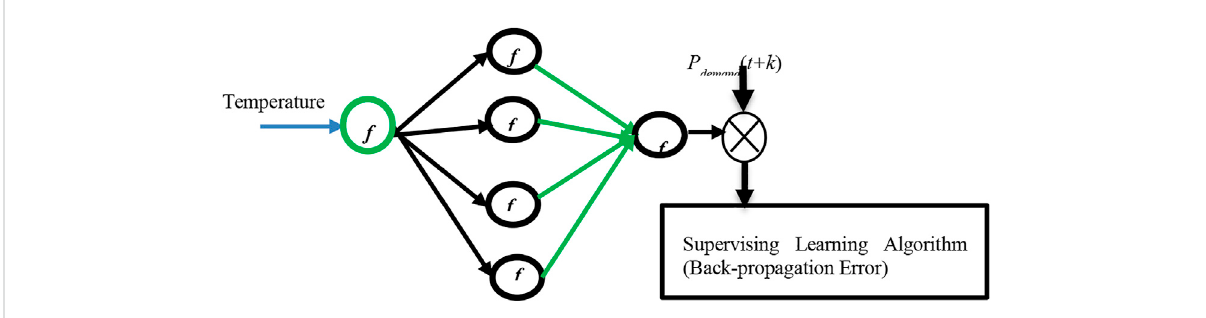
FIGURE 4 Architecture of ANN for forecasting demand power.